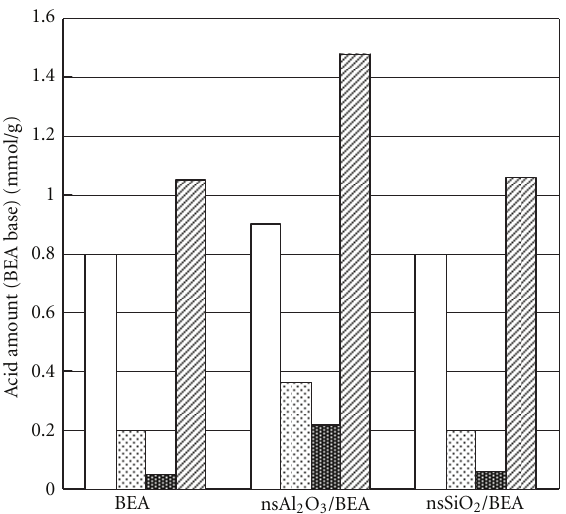
Figure 3: Generated acid sites at the boundary between ns Al 2 O 3 and H-beta Zeolite. White region: weak acid sites ∗ 1; dotted region: mild moderate acid sites ∗ 2; black region: mild strong acid sites; shaded region: total acid sites ∗ 3 ∗ 1: 200 ◦ C peak; ∗ 2: 310 ◦ C peak; ∗ 3: 410 ◦ C peak.